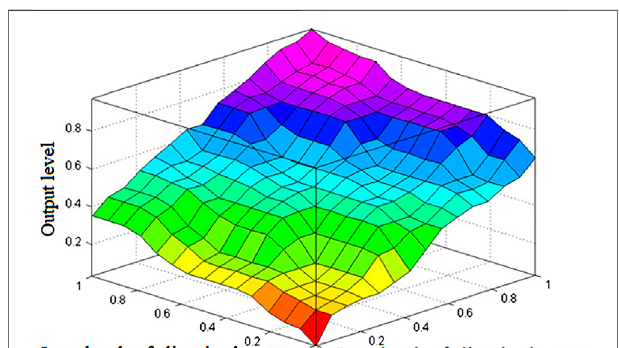
FIGURE 3 | Outline plan for the establishment of a solar panel at the environmental level.